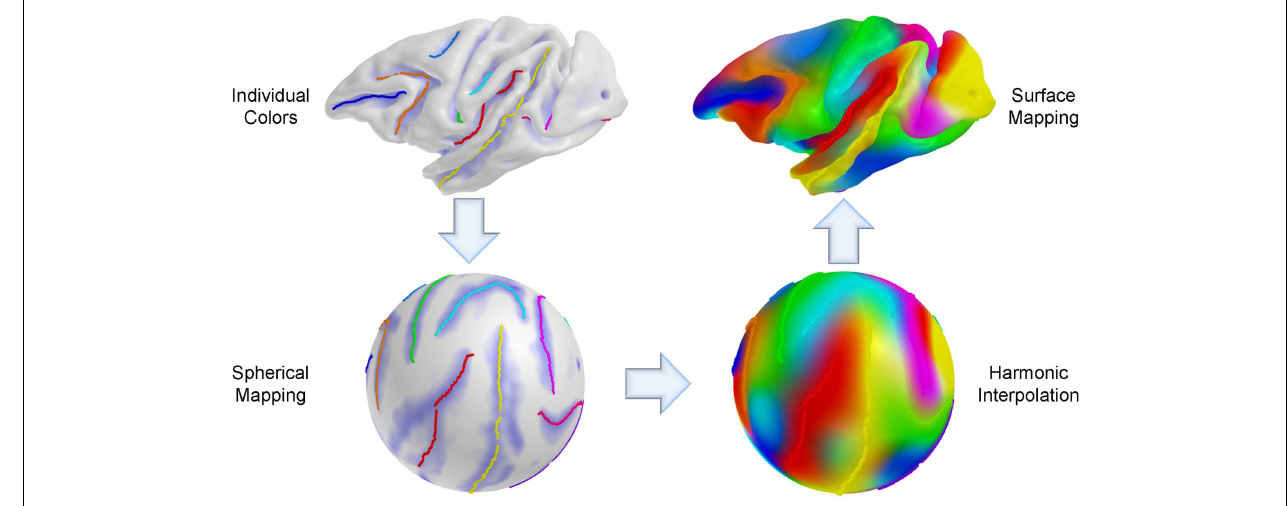
channel, a color intensity is interpolated with a combination of harmonic basis functions, and the color maps obtained via interpolation are remapped onto the original space (cortical surface).